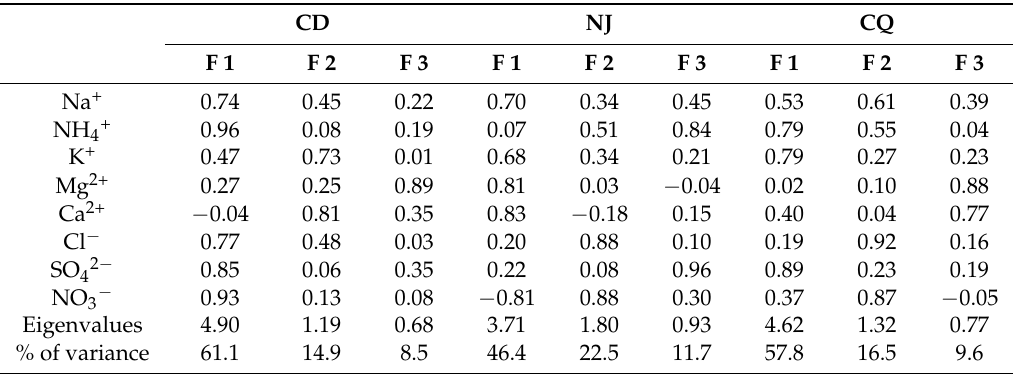
Table 5. PCA factor loadings of WSIIs in CD, NJ, and